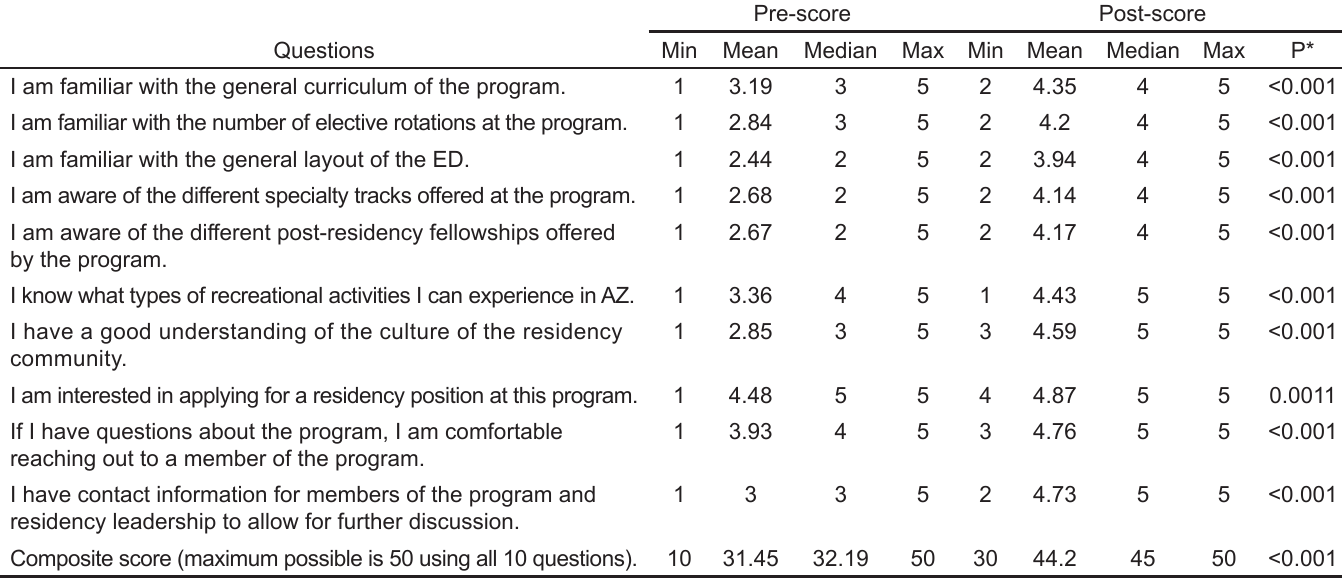
Table 3. Knowledge score comparison before and after the virtual town hall meetings with medical students (n = 75 pre-post paired responses).